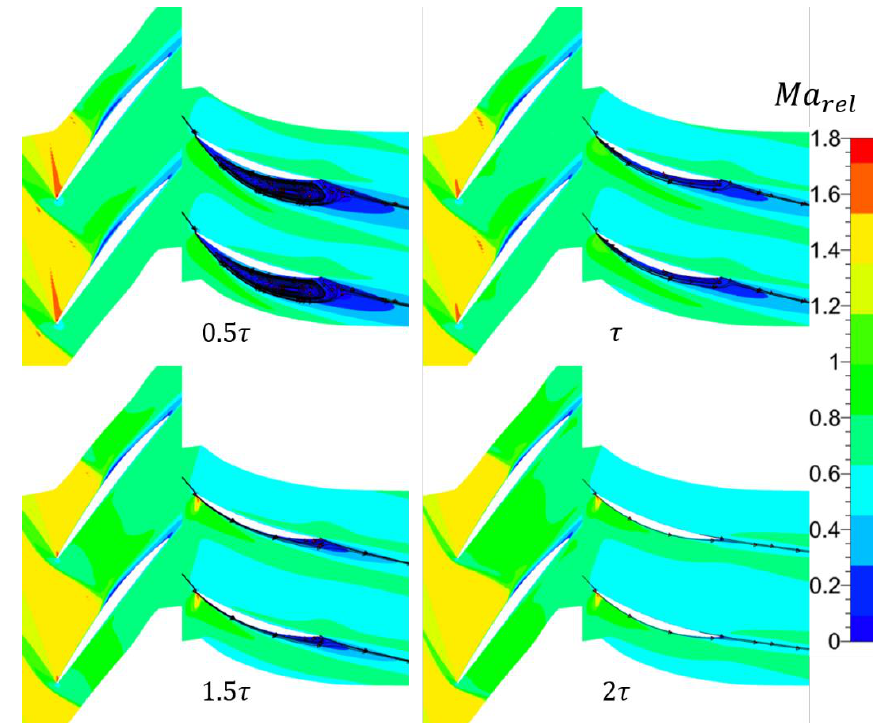
Figure 20. Relative Mach number contours at stage mid-span at the near stall point.